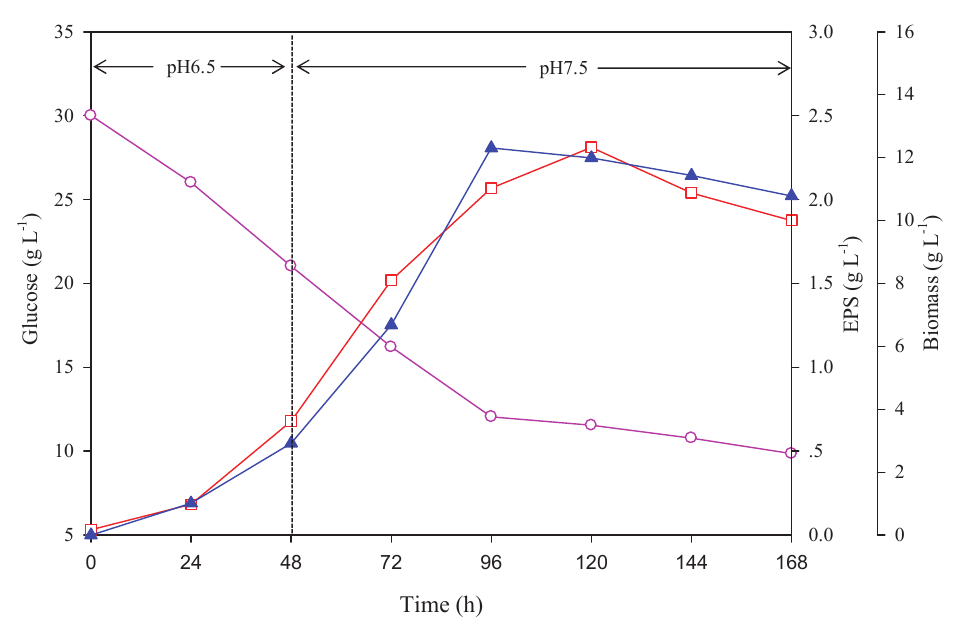
Fig. 5 – Time courses of submerged culture of H. marmoreus in 5-L fermenter under two-stage pH strategy. EPS (▲), biomass (□) and glucose